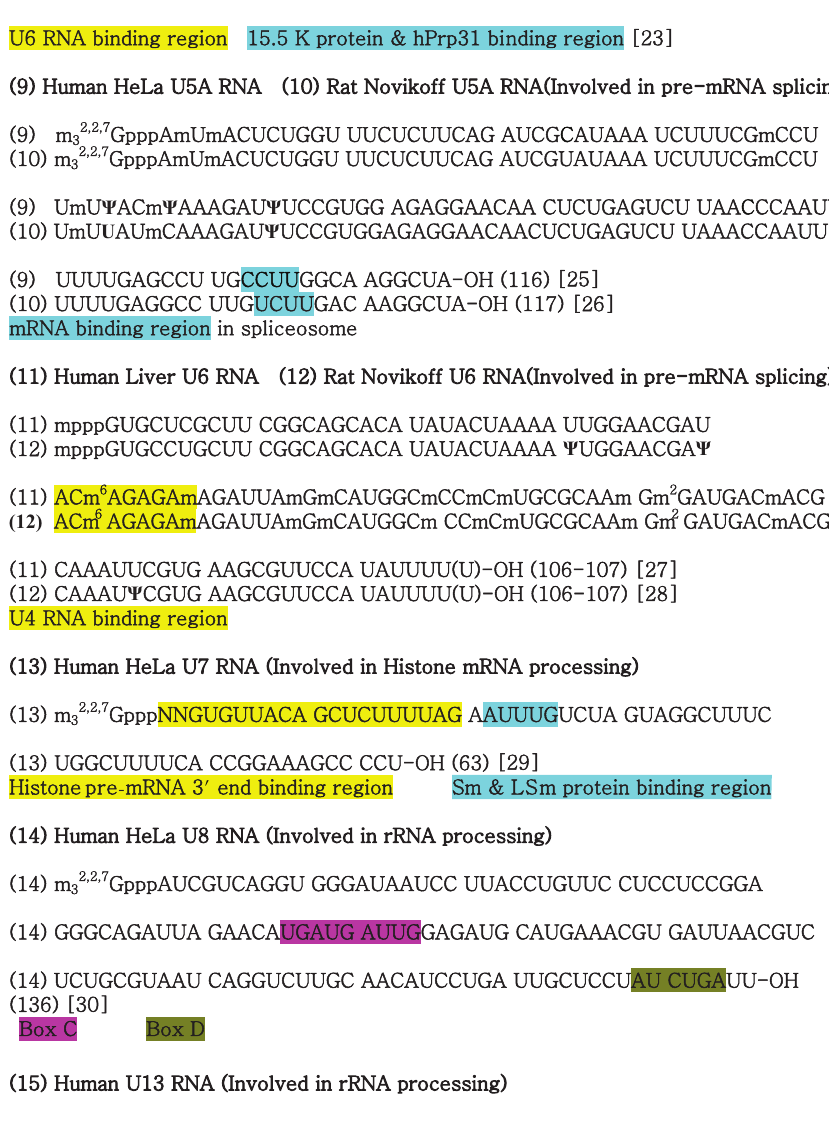
A, showed enzyme-resistant oligonucleotide eluting close to the pentanucleotide region on a DEAE column (Figure 15). The 5 (cid:2) oligonucleotide was analyzed by UV, [ 3 H], and [ 32 P] methods. 8.1.1. The UV Analysis. The 5 (cid:2) oligonucleotides from U1 RNA, obtained by RNase A and RNase T1, were digested with